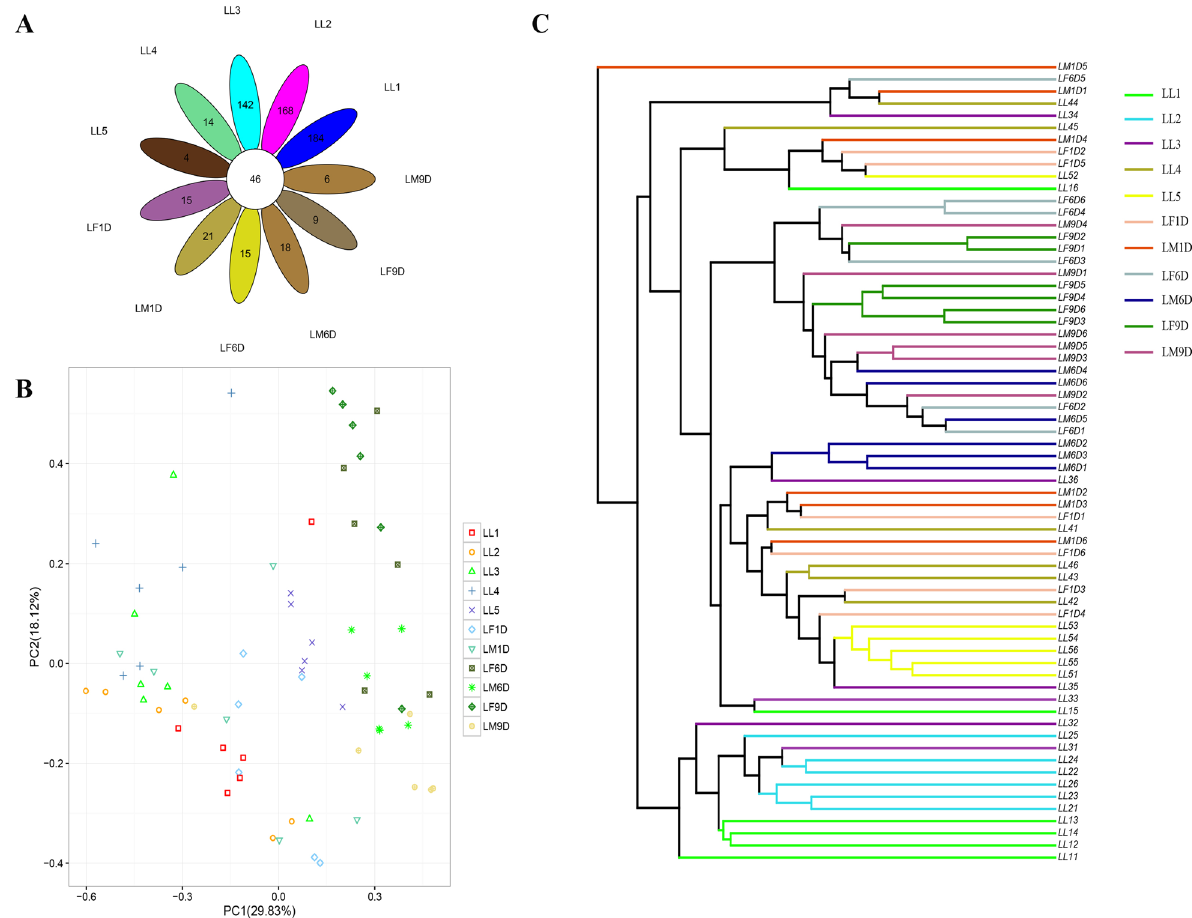
Fig. 3 Bacterial community dynamics among different developmental stages in A. lucorum . A Flower of OTU to show common and unique OTUs for all samples. B Comparison of bacterial community structures in development stages using unweighted uniFrac metrics. C Unweighted pair-group method with arithmetic means (UPGMA) analysis of microbial community structure based on 16S rRNA gene amplicon sequencing